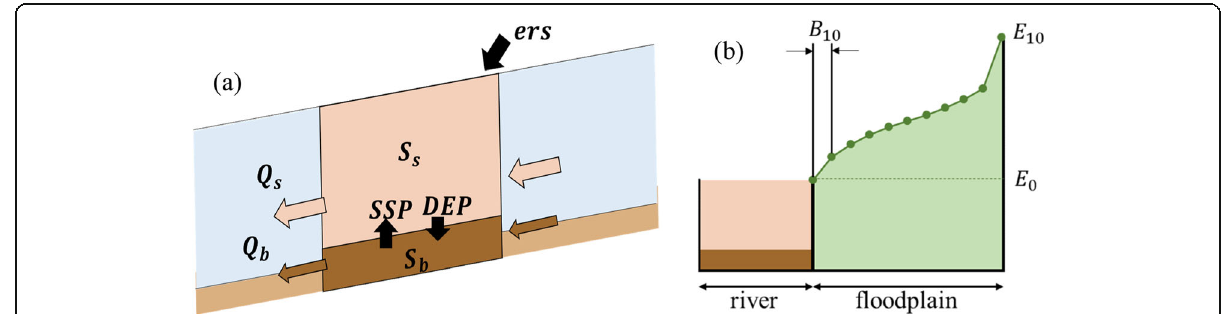
Fig. 1 Schematic of a sediment dynamics in each grid and b estimated slopes of the floodplain. S s , S b , Q s , and Q b are suspended sediment storage, bedload storage, suspended sediment flow, and bedload flow, respectively. SSP, DEP, and ers are suspension, deposition, and sediment erosion, respectively. E 0 and E 10 are the elevation [m] of river channel and last tenth percentile, respectively. B 10 is the width for every tenth percentile [m] of the